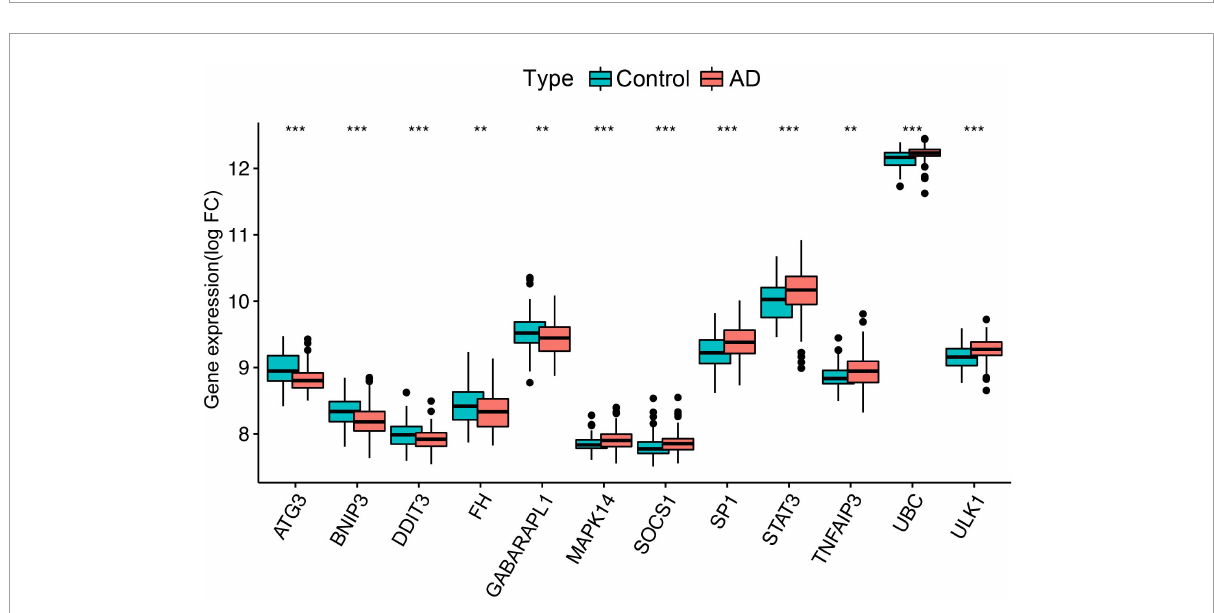
FIGURE6 Differential expression of the 12 ferroptosis-related genes between normal controls and AD, ** p < 0.01; *** p < 0.001. FC, fold